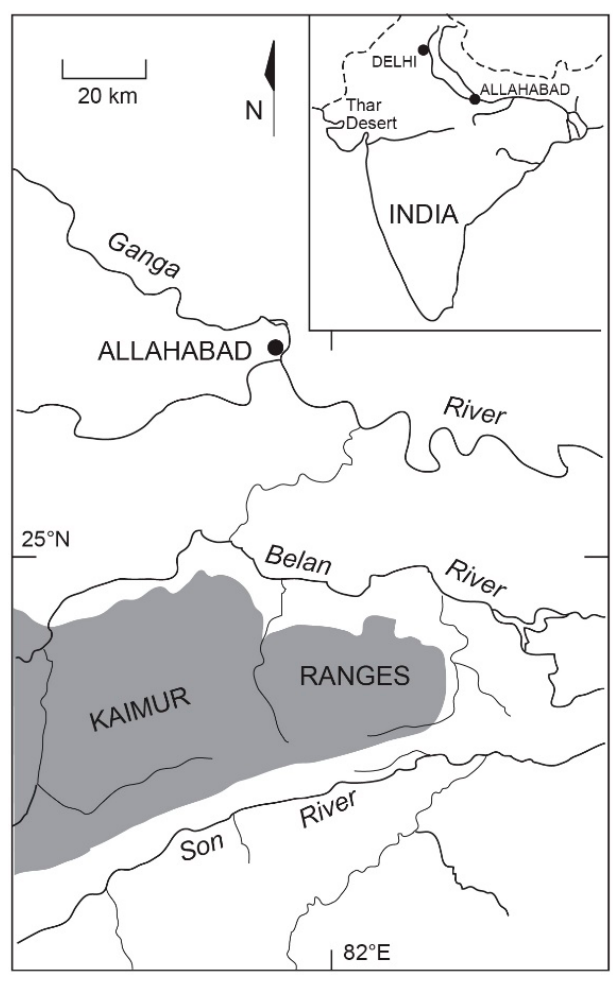
Figure 7. Location of Son and Belan Rivers in north ‐ central India.